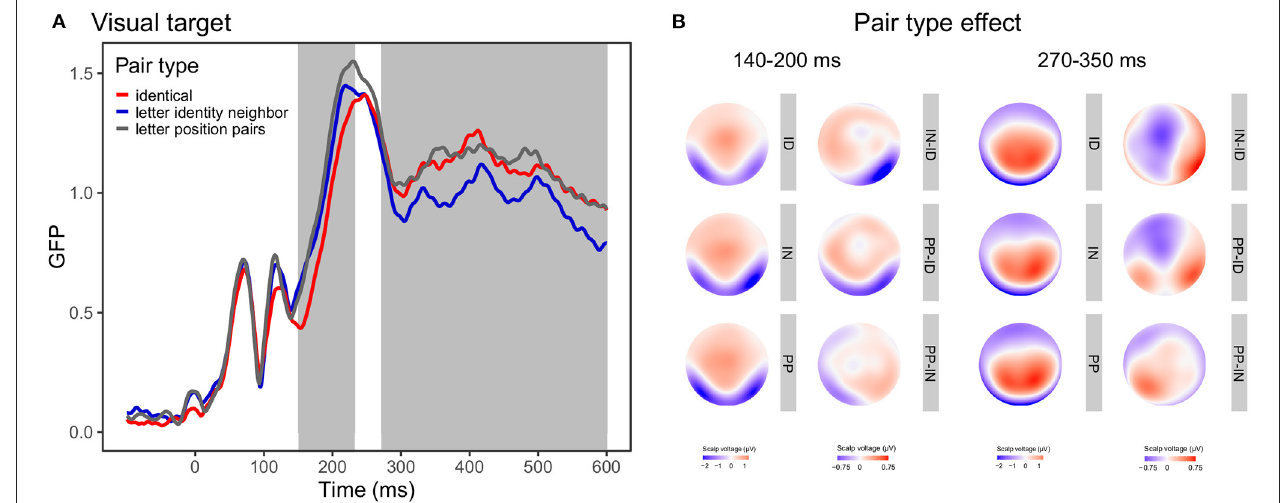
FIGURE 5 | Global field power (GFP) curves and topographic maps for the pair type effect in visual target stimuli. (A) GFP for the identical, letter identity neighbor, and letter position pair targets. Gray areas highlight the time windows in which the effect was significant according to the GMD analysis. (B) Topographic maps for the pair type conditions (ID, identical; IN, letter identity neighbor; PP, letter position pairs) and the pair type differences averaged between 140-200ms representing the first time window and between 270–350ms representing the second time